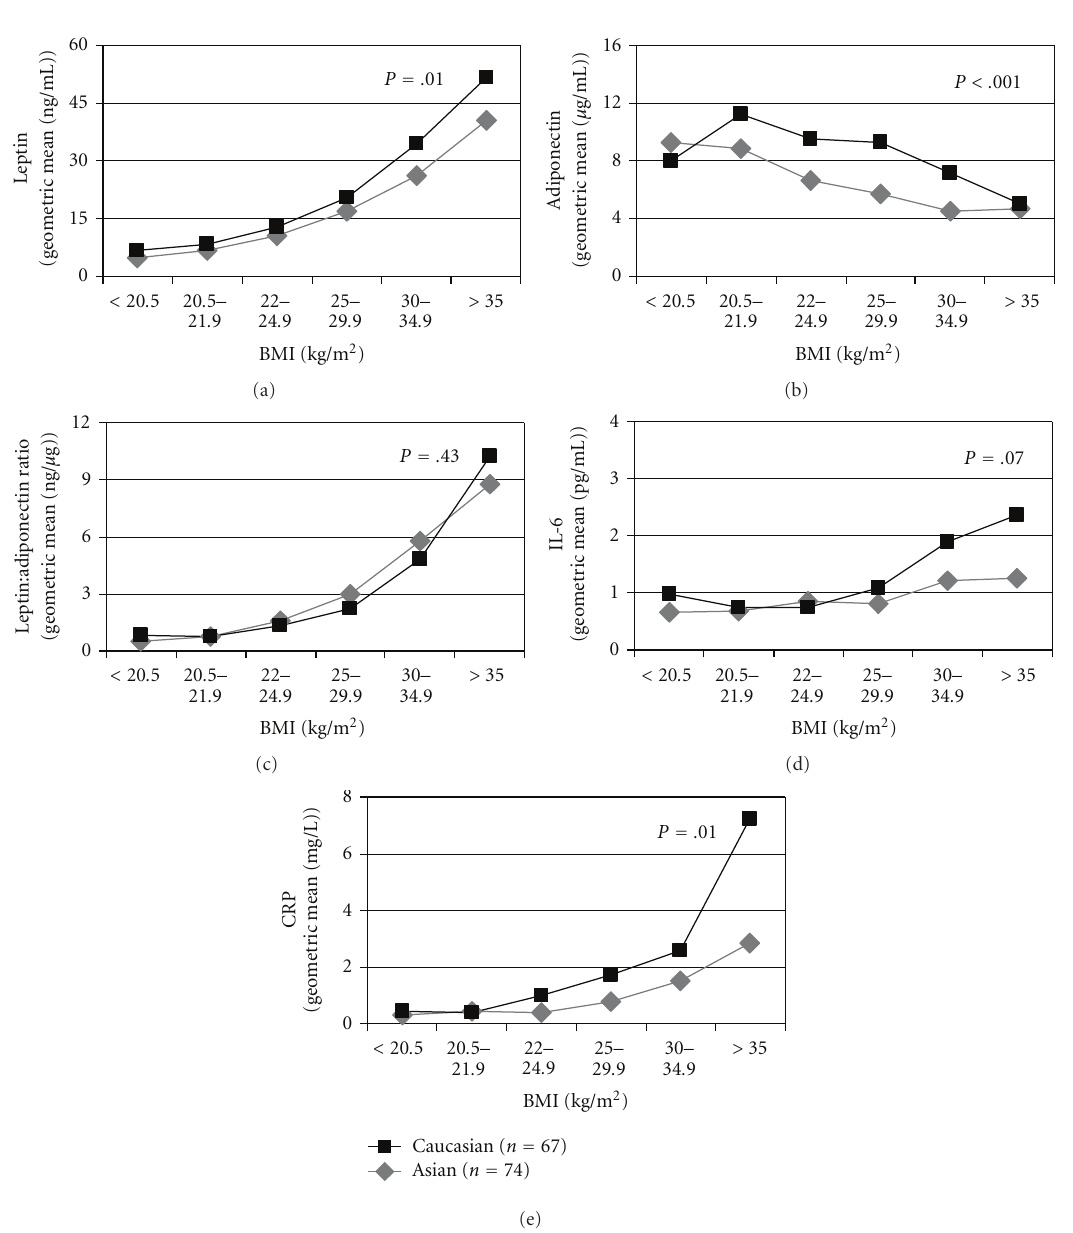
Figure 1: Ethnic di ff erence in the biomarkers by BMI level. Abbreviations: BMI: body mass index; IL-6: Interleukin-6; CRP: C-reactive protein. a P value s for ethnic heterogeneity from analysis of variance with log transformed values and adjusted for BMI